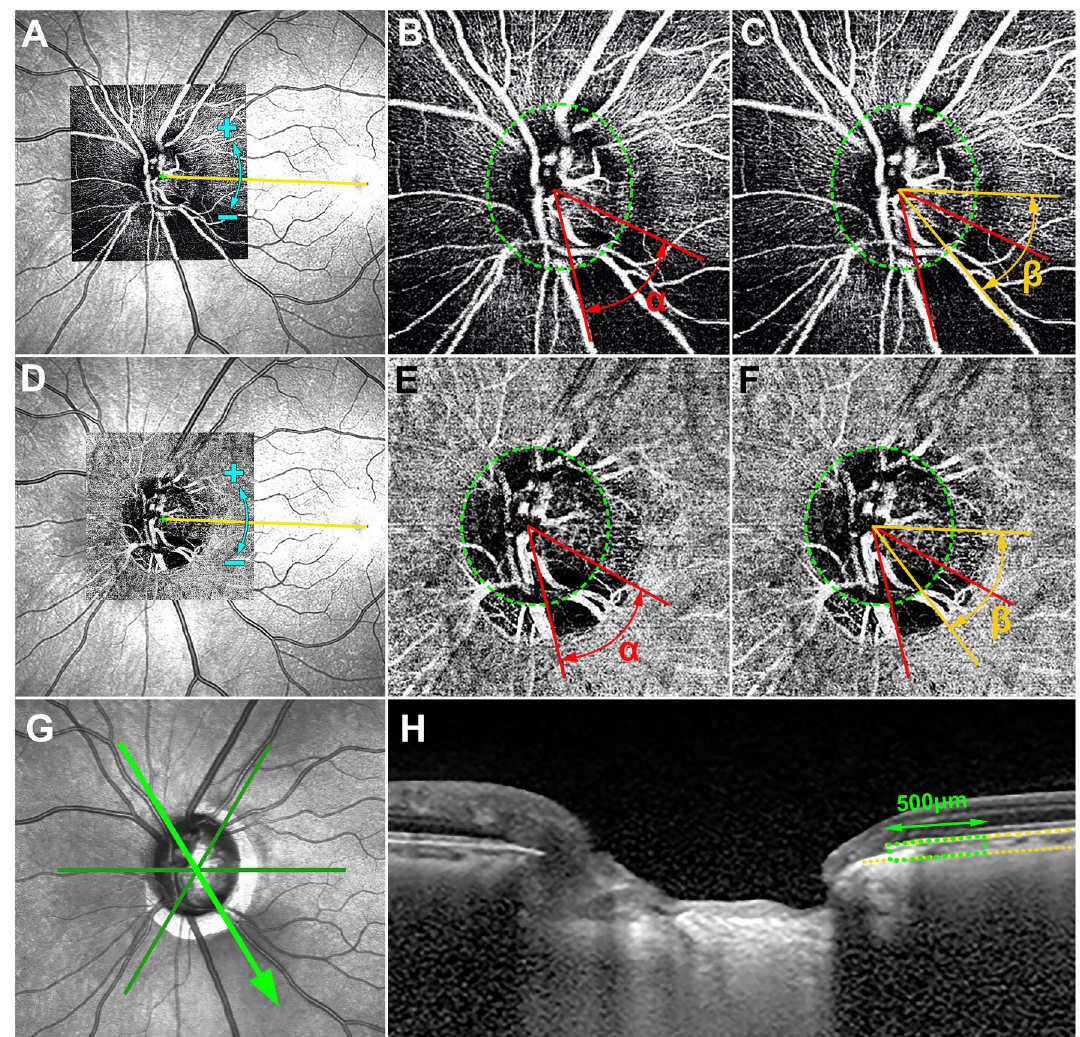
Figure 5. Determination of the circumferential extent and location of retinal microvascular impairment (RMvI) and choroidal microvasculature dropout (CMvD) and juxtapapillary choroidal thickness (JPCT). En-face OCTA images of the retinal ( A – C ) and choroidal ( D – F ) layers were superimposed and manually aligned on the infrared fundus photographs to determine the foveal-disc axes ( yellow lines , A , D ). Positive and negative angles indicated the locations that were superior and inferior relative to the foveal–disc axis, respectively ( A , D ). Green dashed ellipses indicate optic disc margins ( B , C , E , F ). The circumferential widths of RMvI and CMvD were measured as the angular distances between the two points at which the borders of the RMvI or CMvD area met the clinical optic disc margins (α, B , E ). The locations of the RMvIs and CMvDs were defined as the angular distances between the foveal-disc axis and the midpoint dividing the red lines , indicating the circumference of the RMvI or CMvD (β, C , F ). Three radial B-scans were selected for the evaluation of the JPCT ( green lines , G ). The image in ( H ) shows one of the radial B-scans that was obtained along superonasal to inferotemporal meridian ( green arrow , G ). Yellow dotted lines indicate the upper and lower margins of the parapapillary choroid ( H ), and the area of the choroidal tissue within 500 μm from the border tissue of Elschnig ( green dotted square ) was measured using the built-in drawing tool of Spectralis viewer software. The mean JPCT was calculated by dividing the area by 500